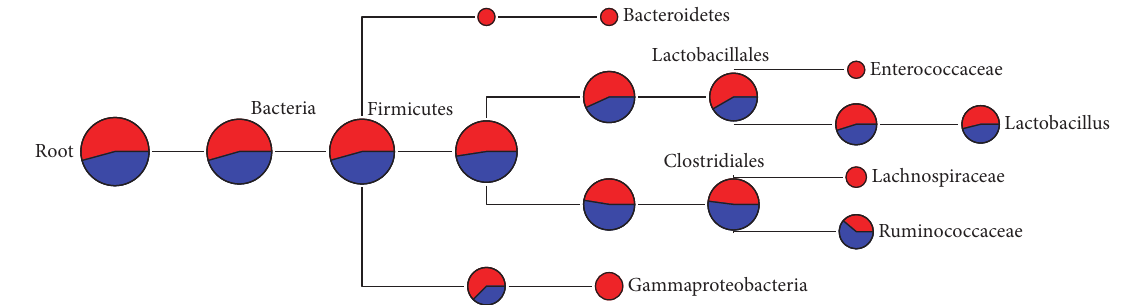
Figure 2: Bacterial diversity of chicken ileal mucosal bacteriome. Only the genera represented by ≥ 5 OTUs each were shown, and the size of each node reflects the total number of OTUs. The relative proportion of taxa from the two pyrosequencing runs was shown by different colors: red, from the first run; blue, from the second